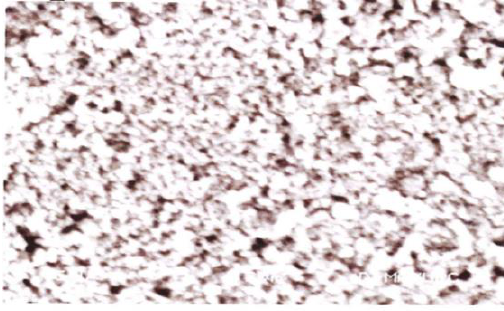
Figure 9. SEM micrographs LaFeO ₃ nanocrystalline particles sintered at 900 °C